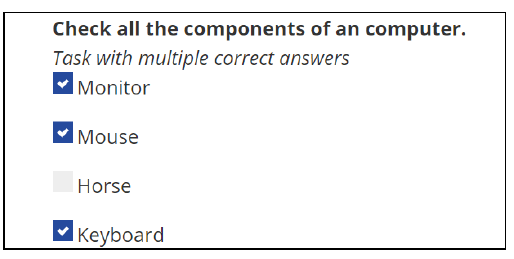
Fig. 4. The result of learning content code generation in the LMS